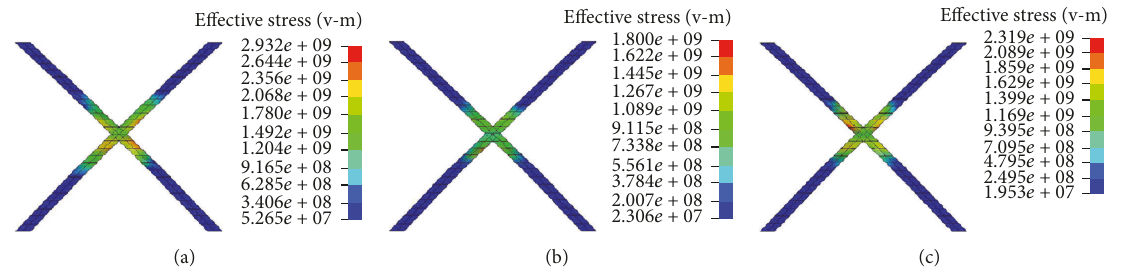
Figure 18: Stress contours of three models: (a) model 7, (b) model 8, and (c) model